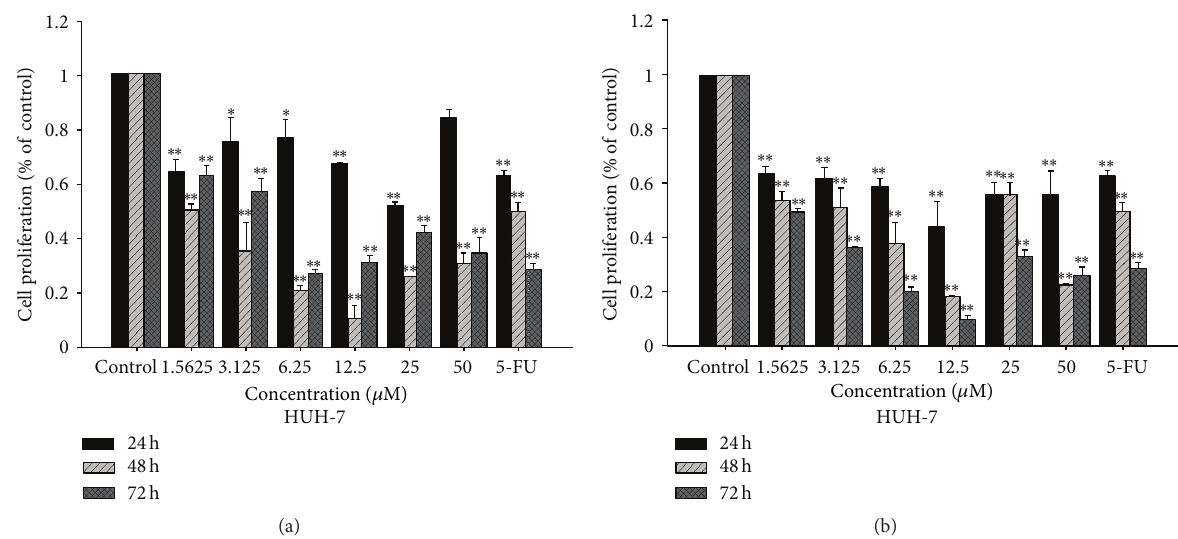
Figure 3: Antiproliferative activity of complexes 1 (a) and 2 (b) detected by MTT assay after 24, 48, and 72 h of treatment on HUH-7 cells.